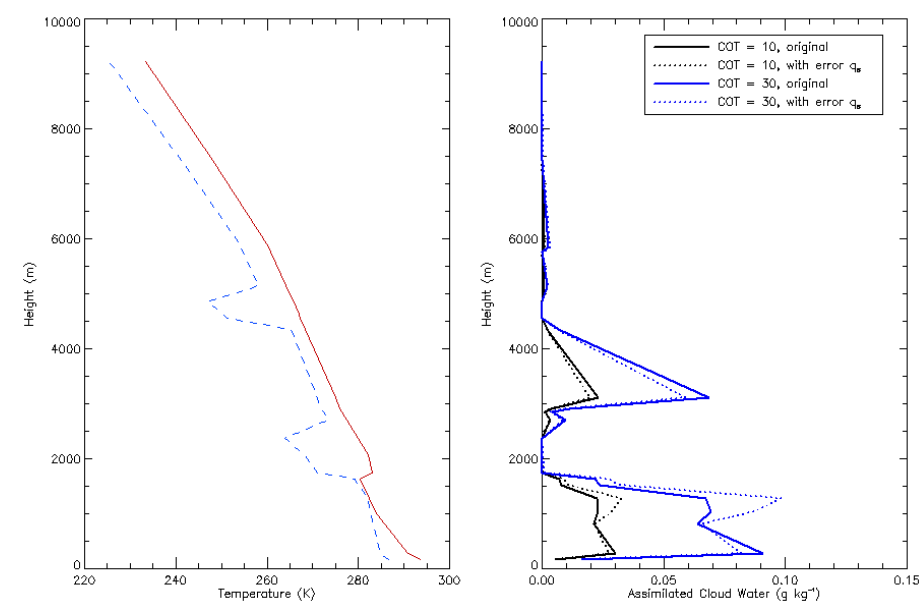
Figure 10: Left: Radio-sounding profile of temperature (red) and dew point temperature (blue) 3 Fig. C1. Left: radio-sounding profile of temperature (red) and dew point temperature (blue) at Trappes on 20 June at 12:00LT. Right: at Trappes on 20 June at 1200 LT. Right: Resulting cloud water profiles from experiments 4 resulting cloud water profiles from experiments including the uncertainty in the background saturated specific including the uncertainty in the background saturated specific humidity. 5